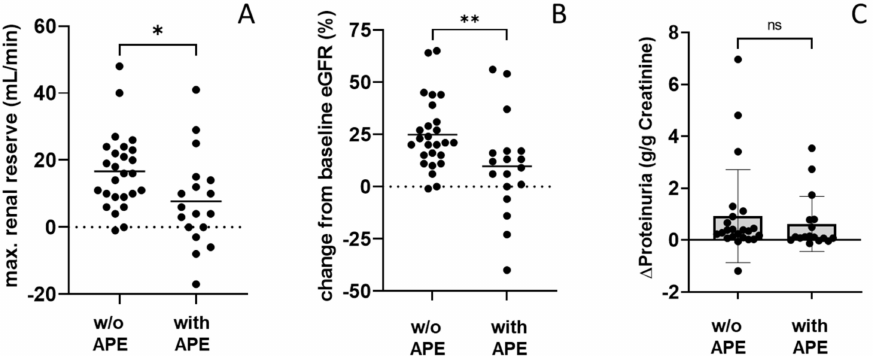
Figure 1. Impact of hyperfiltration during pregnancy and change from baseline eGFR on adverse pregnancy outcome. Maximal (max.) renal reserve expressed as mL/min ( A ) or as the percentage of increase from baseline eGFR ( B ) correlated with a better pregnancy outcome. Change in proteinuria (g/g creatinine) did not differ between pregnancies with and without (w/o) adverse pregnancy events (APE) ( C ). * = p < 0.05, ** = p < 0.01, ns = not